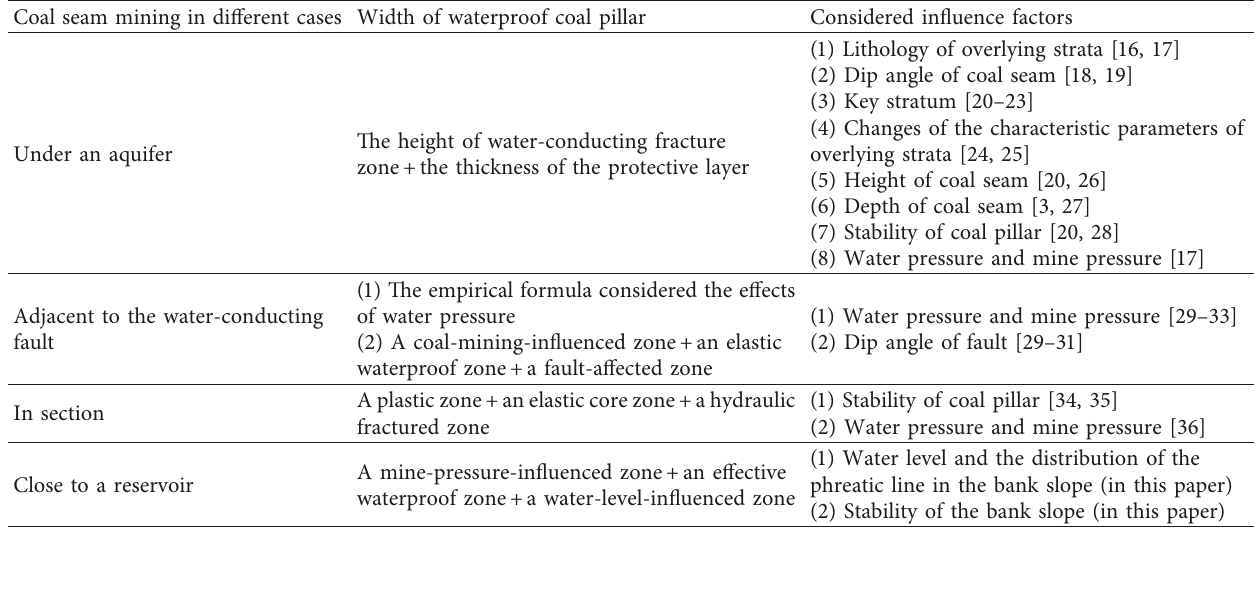
Table 1: Determination methods of the widths of waterproof coal pillars in different